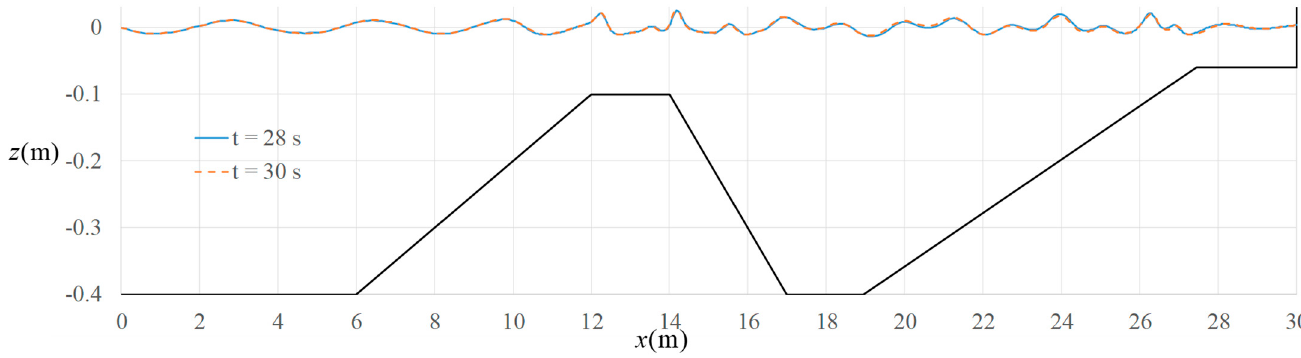
Figure 9. Snapshots of the water surface profiles at t = 28 s and t = 30 s in the simulation of nonlinear modulation of periodic waves passing over a submerged obstacle.